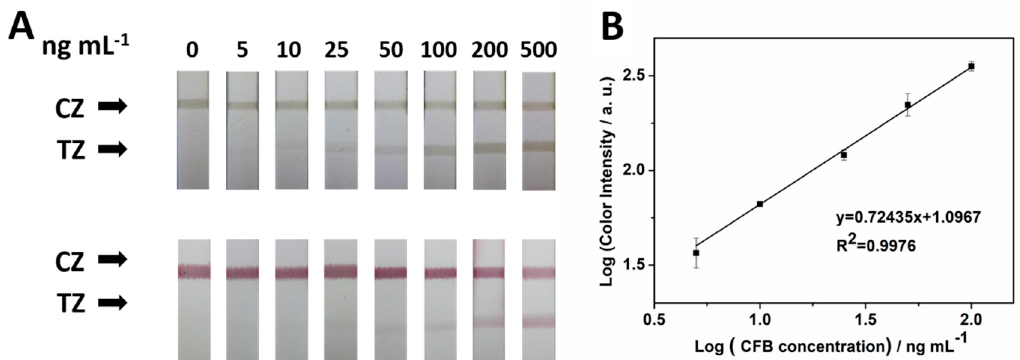
Figure 4. ( A ) Photo images of LFI showing CFB serial dilutions and detection with MCNT (top) and Gold nanoparticle (GNP) (bottom). ( B ) The linear range for CFB detection using MCNT.